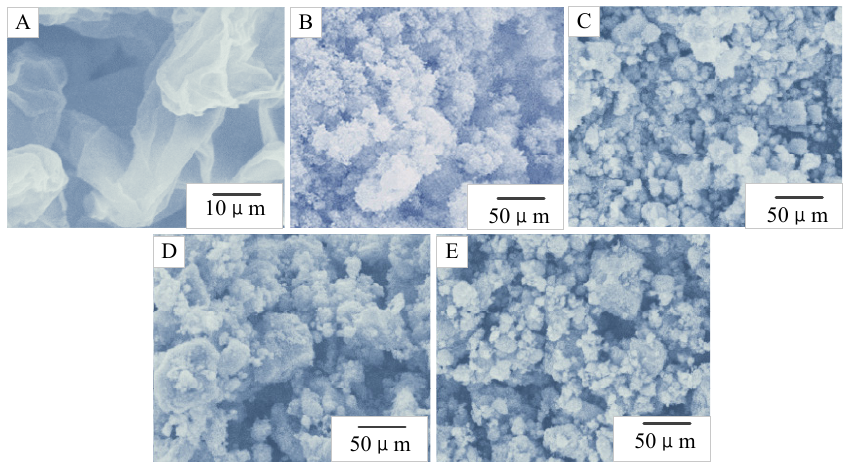
Figure 2. SEM images of the GO composite photocatalysis materials (( A ) GO; ( B ) TiO 2 ; ( C ) N-TiO 2 ; ( D ) TiO 2 /GO; ( E ) N-TiO 2 /GO).